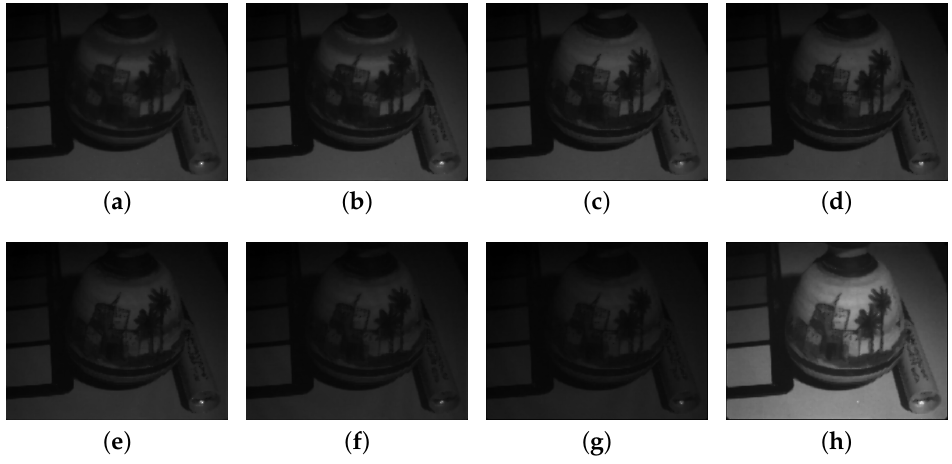
Figure 12. Demosaiced image by Miao binary tree algorithm. Channels 1 to 8 are reconstructed to provide a full resolution multispectral image. These data are encapsulated in one single tiff file for storage in Supplementary Materials. ( a ) Channel P1; ( b ) Channel P2; ( c ) Channel P3; ( d ) Channel P4; ( e ) Channel P5; ( f ) Channel P6; ( g ) Channel P7; ( h ) Channel IR. Demosaiced image is provided as a tiff